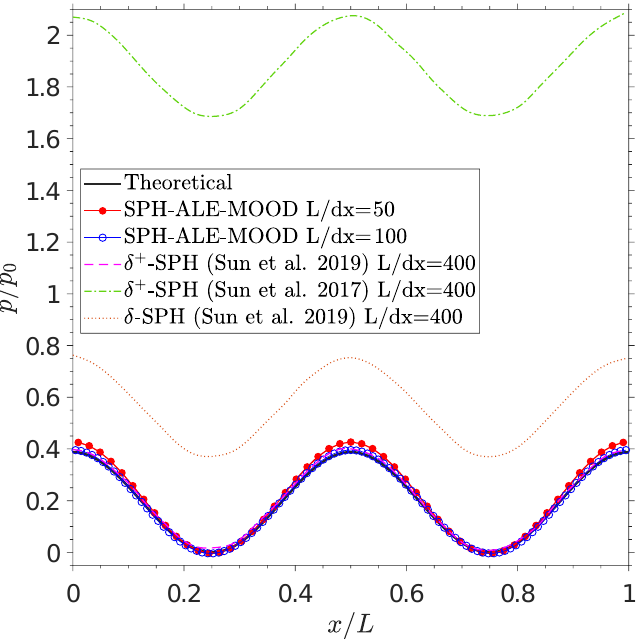
Figure 13. Taylor Green flow: Comparison of the pressure field along y = 0.5 L for Re =